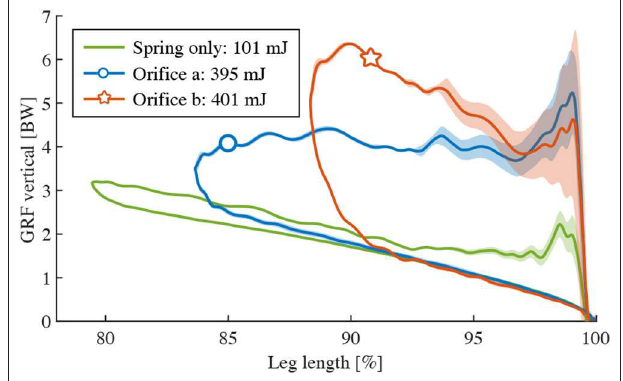
FIGURE 10 | Higher energy dissipation with a different model of the hydraulic damper (1210M): Vertical GRF vs. leg length change, a 2-DOF leg with a parallel damper and spring drops onto the force sensor. Two damper orifice settings were tested (blue, red curves). The two resulting curves are compared with the spring-only configuration, provided as